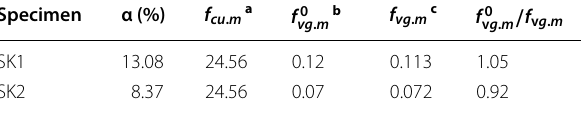
Table 8 Comparison of measured shear strength and formula value (MPa).